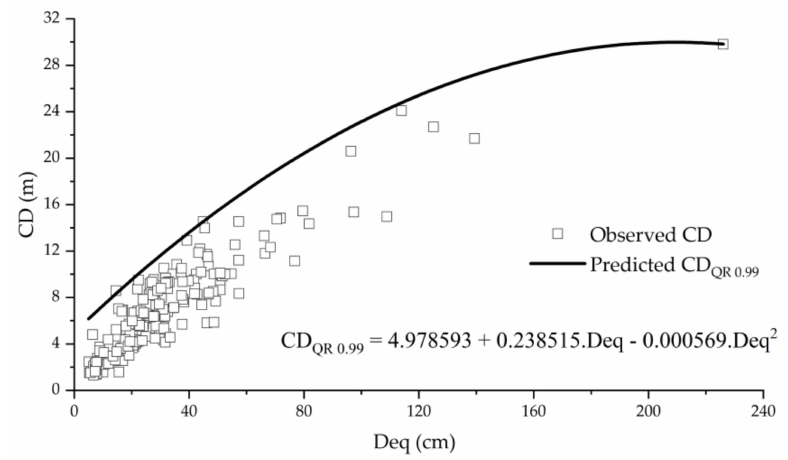
Figure 6. Determination of the trend of potential crown diameter via quantile regression techniques in open-growing trees, in which Deq refers to the diameter measured 1.3 m above the soil, and CD, to crown diameter.